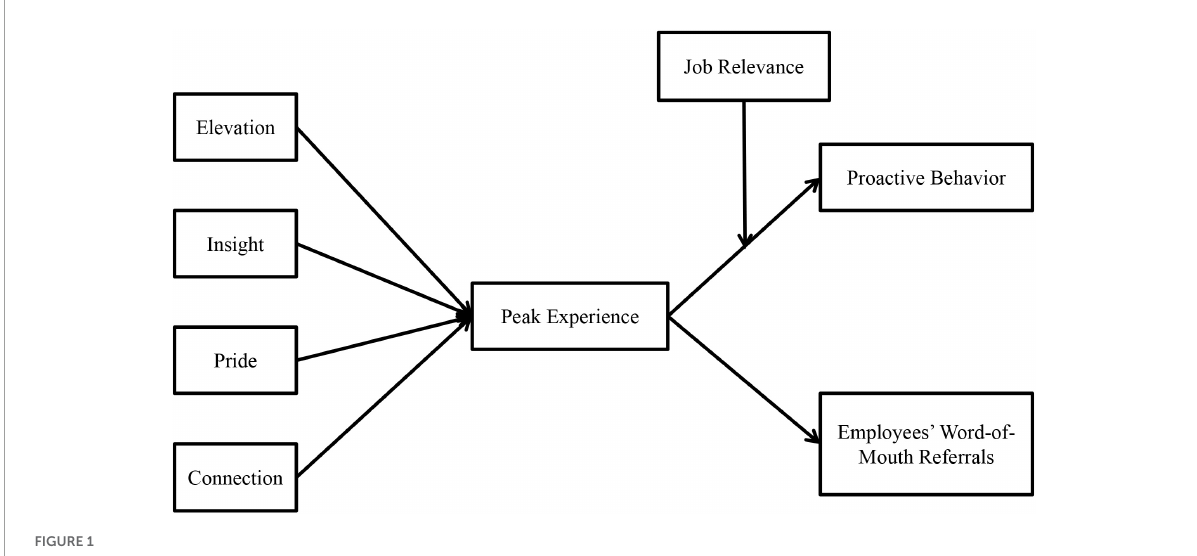
FIGURE1 Theoretical